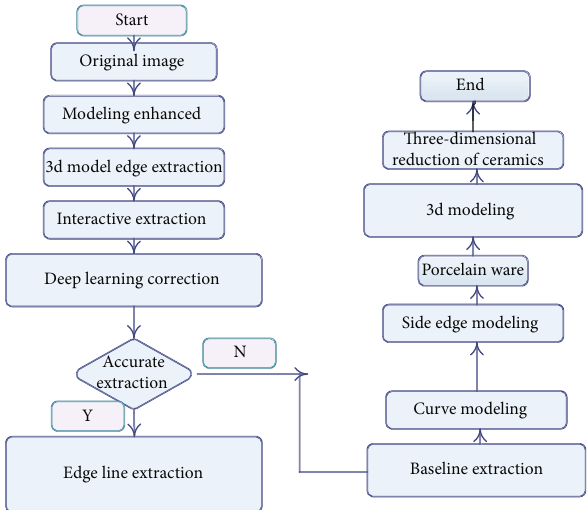
Figure 2: 3D image modeling algorithm fl ow of ceramic shape deep